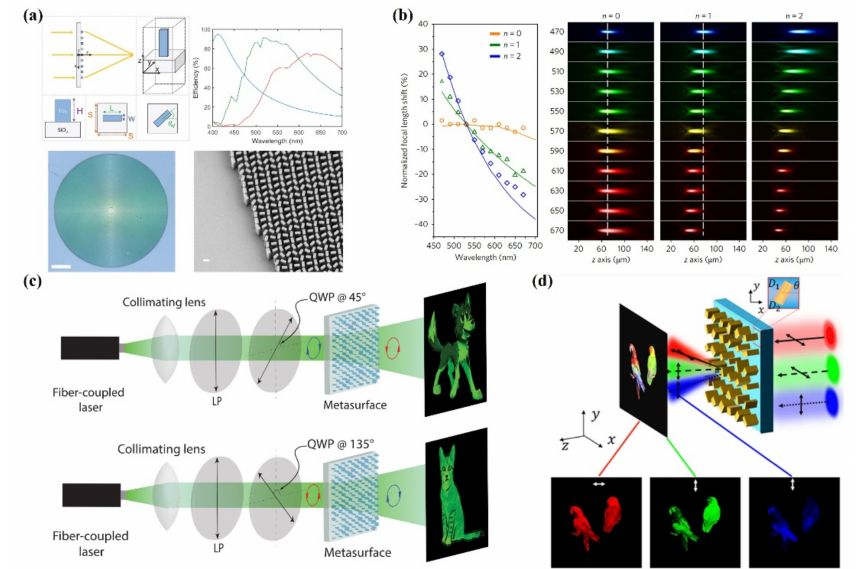
Figure 4. ( a ) TiO 2 metalens. The unit cell is a nanofin (top left); its PCE is illustrated in the top right [78]. ( b ) Experimentally measured focal length for TiO 2 achromatic metalenses [79]. ( c ) Polar- ization multiplex metahologram [77]. ( d ) Trichromatic metahologram